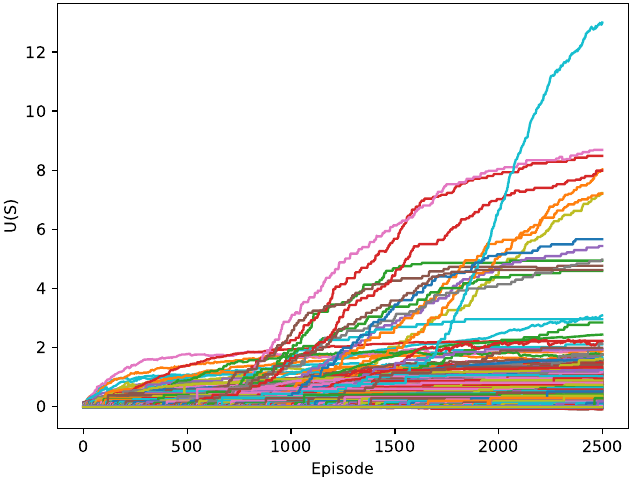
Figure 6. Evolution of the utility for all the states in the RL-DOVS-A